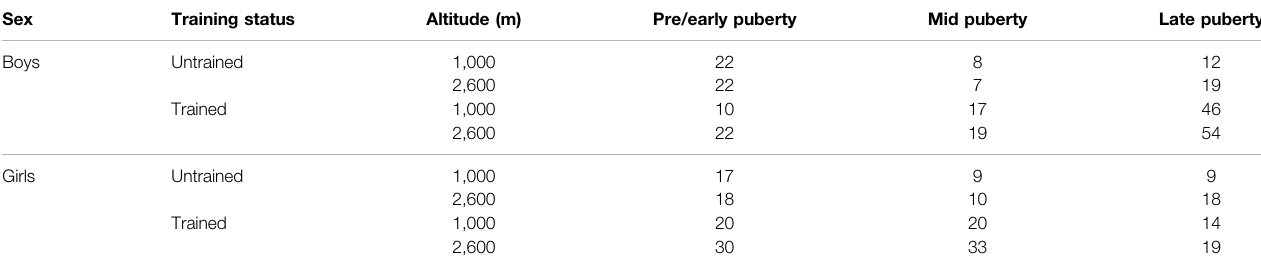
TABLE 1 | Number of participants in the respective subgroups.